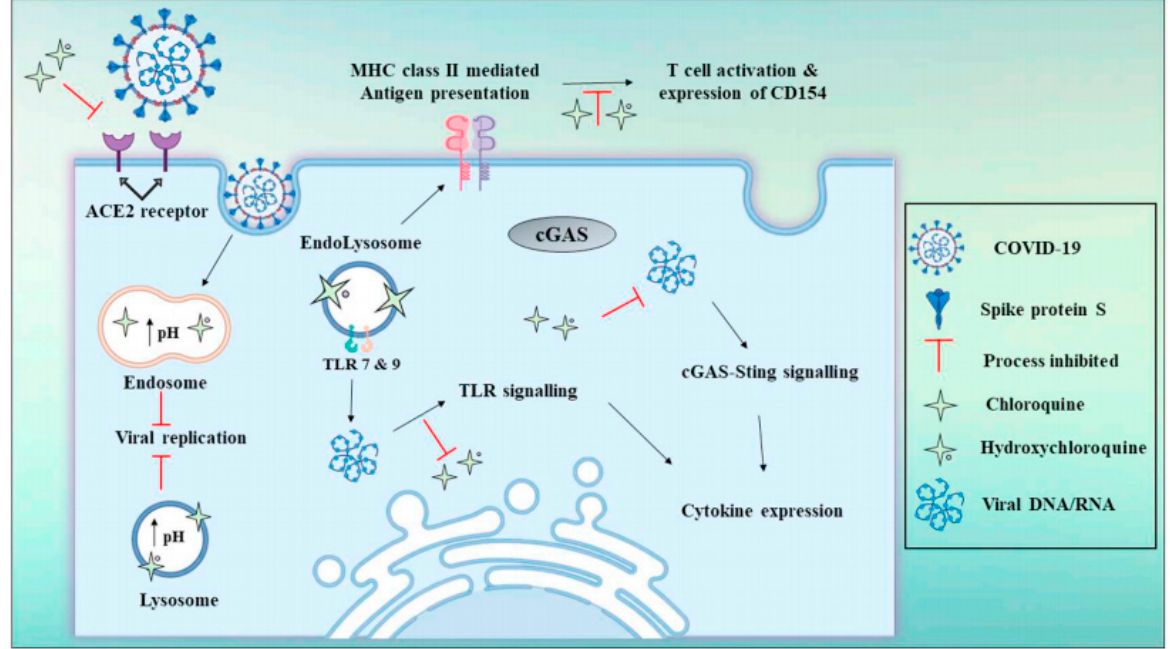
Figure 5. Schematic of the antiviral mechanisms of chloroquine and hydroxychloroquine. These drugs block SARS-CoV-2 invasion as well as reduce the risk of cytokine storm by preventing T cell activation. Reproduced from [141] with permission from Elsevier.